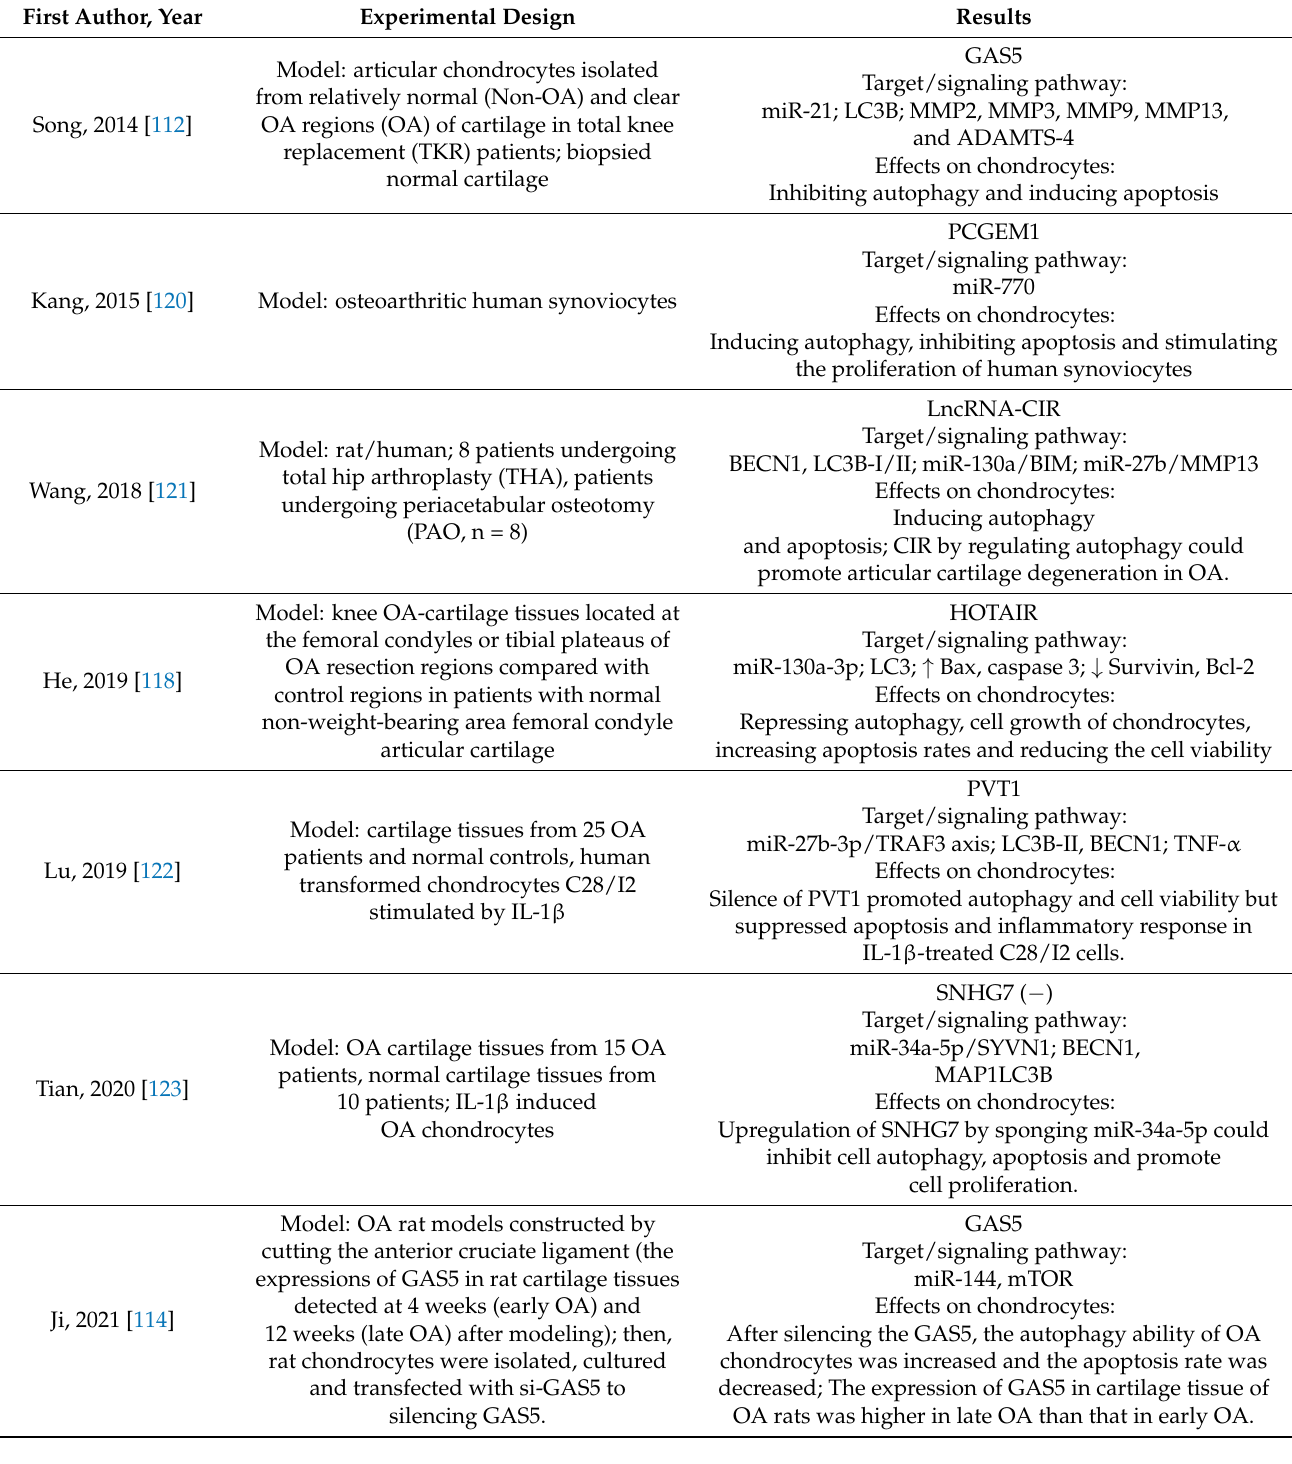
Table 1. LncRNA regulation of autophagy in